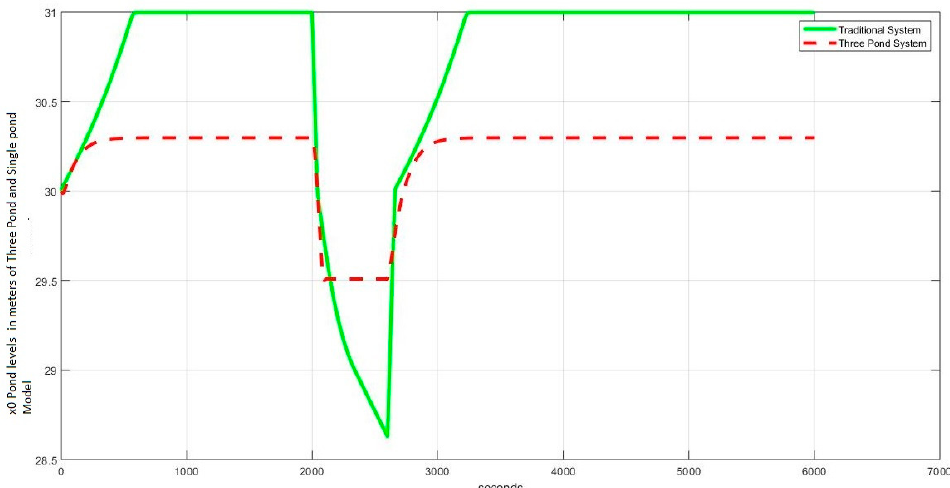
Figure 36. Traditional system vs. Proposed system (half) (negative surge, steady state).